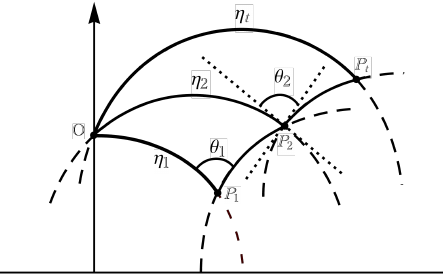
Figure 4. Distance travelled after the second Poisson event.